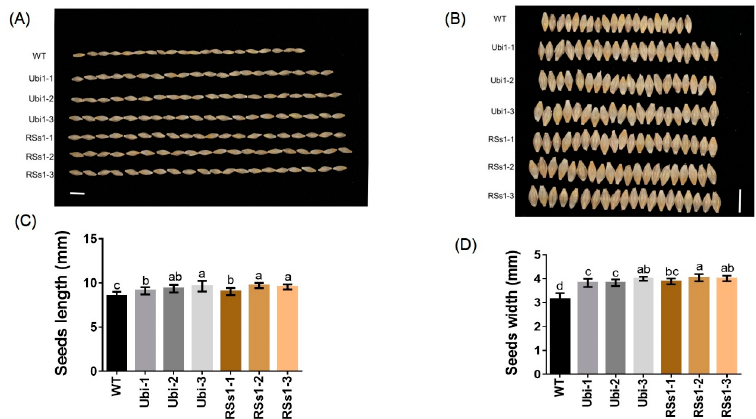
Figure 4. Comparison of seed morphology in barley plants ( A ), ( B ) seed morphology images of all barley plants. Bars = 1 cm. ( C ) The length and ( D ) width of seeds. Different letters indicate a significant difference between transgenic lines and WT ( p < 0.05, one ‐ way ANOVA). Error bars: standard error ( n = 4 plants). Bars = 1 cm.